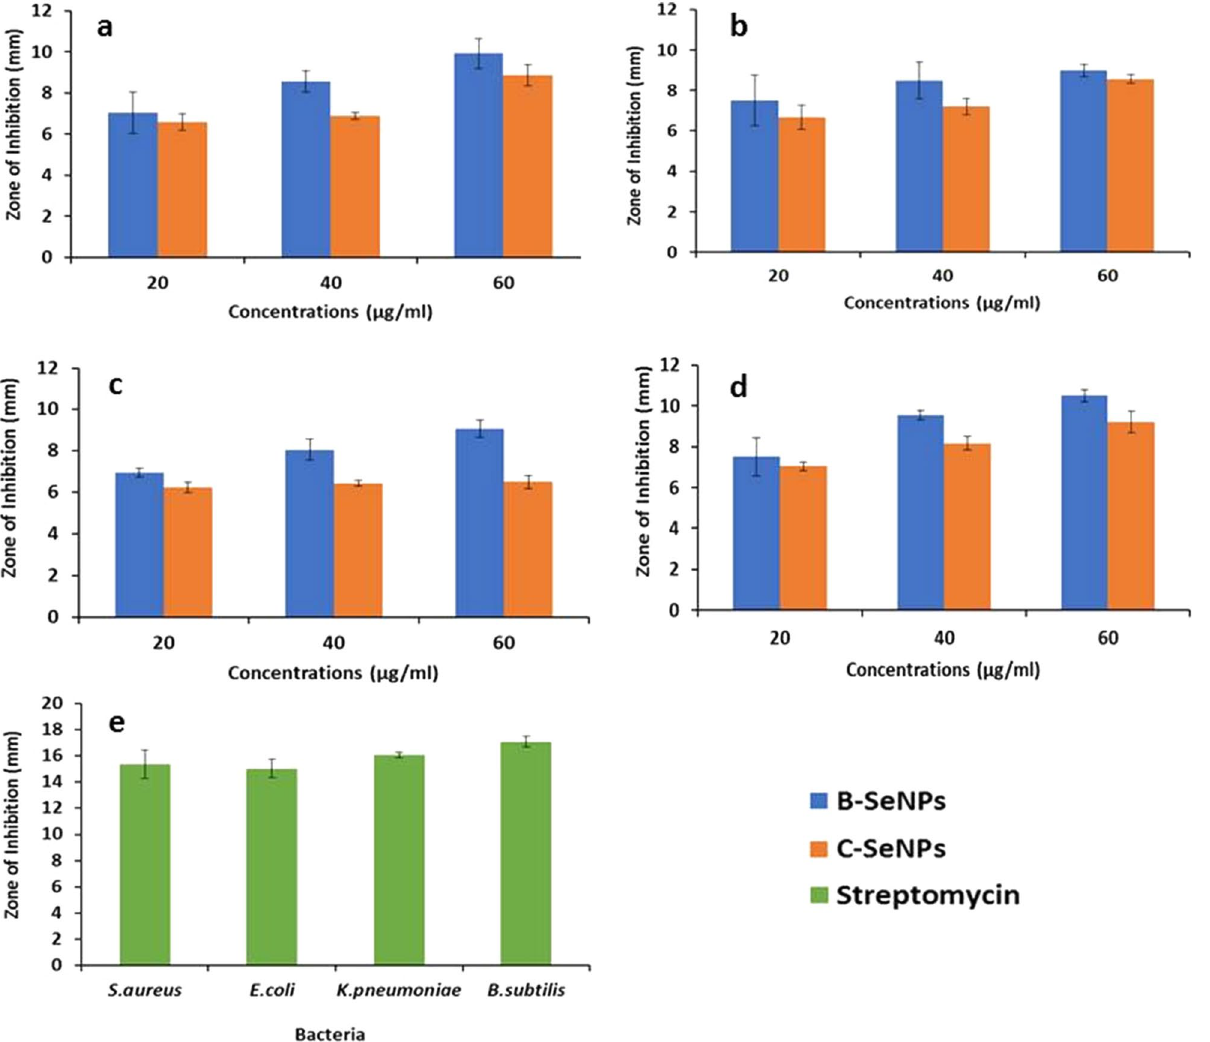
Figure 6. Comparative anti-bacterial activity of B-SeNPs and C-SeNPs by disc diffusion assay ( a ) S. aureus ( b ) E. coli ( c ) K. pnuemonae ( d ) B. subtilis ( e ) Streptomycin.